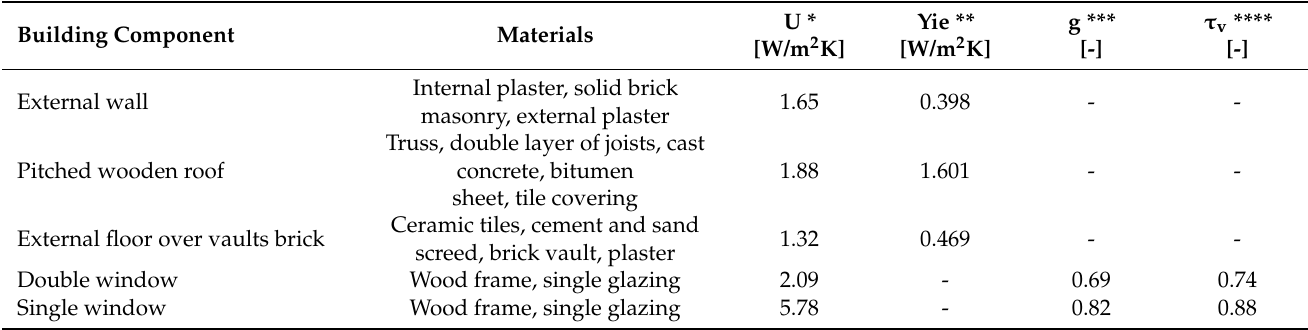
Table 2. Thermal and optical properties of the existing building envelope of Vasari